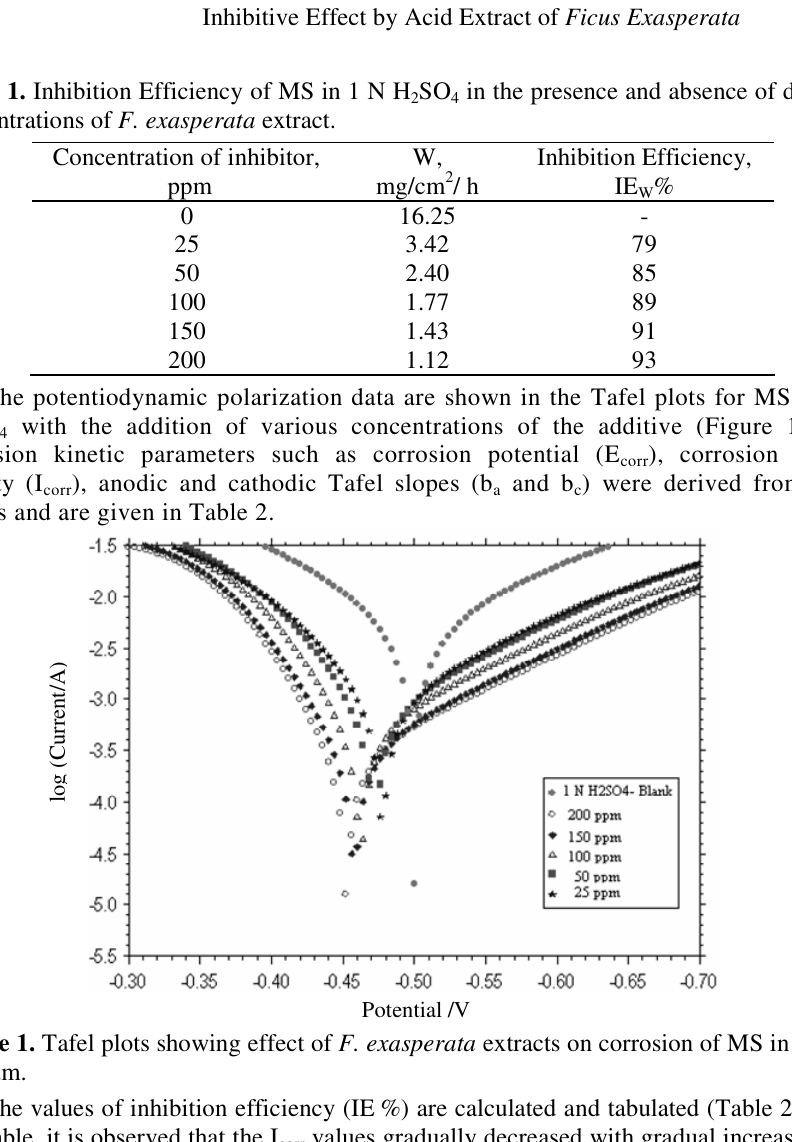
SO in the presence and absence of different 2 4